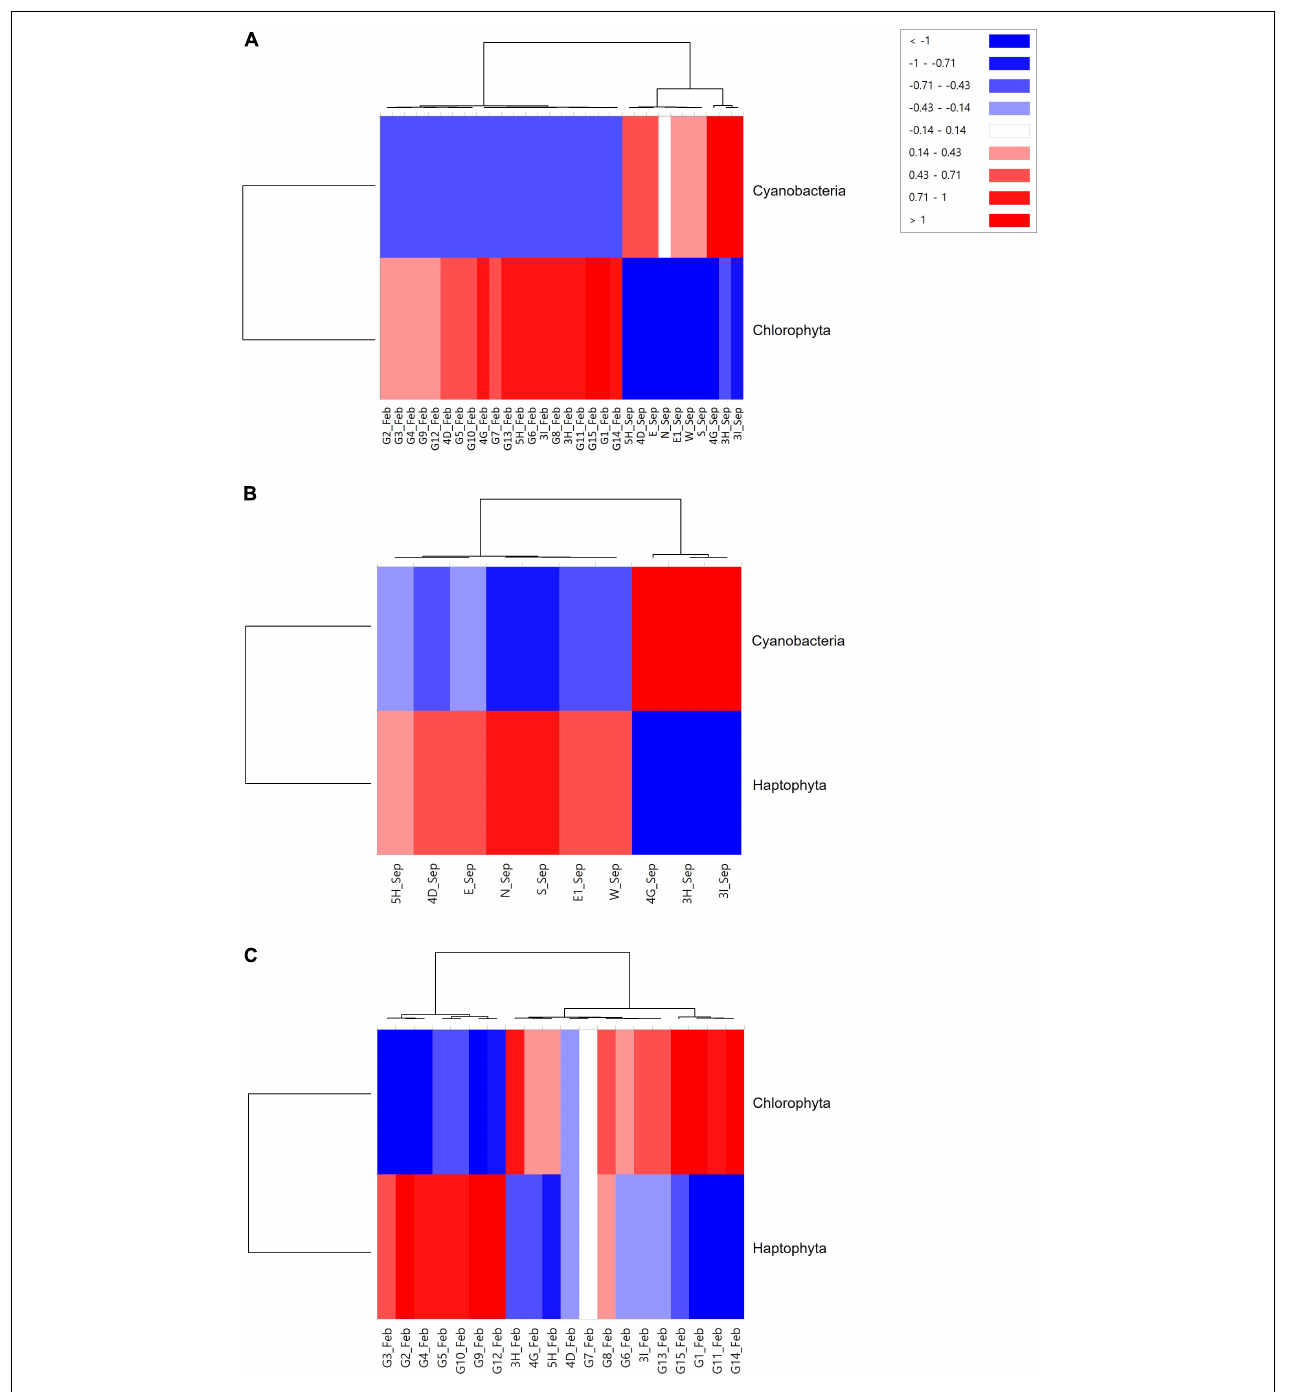
FIGURE 7 | Heatmap analysis for phytoplankton at the phylum level identified at each sample collection site [ (A) Merge; (B) September; and (C)